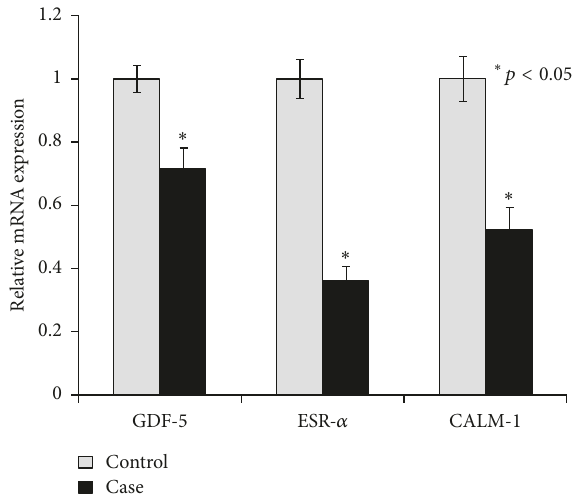
Figure 2: Quantitative real time PCR analysis was performed for relative mRNA expression of genes involved in cartilage synthesis and repair in control and case study. Quantitative analysis suggested that expression of GDF5, ESR- 𝛼 , and CALM-1 genes downregulated incasegroupcomparedtotheirrespectivecontrol. 𝛽 -Actinservedas housekeeping gene for normalization. Values are expressed as mean ± SEM ( 𝑛 = 24 ). ∗ 𝑝 < 0.05 versus